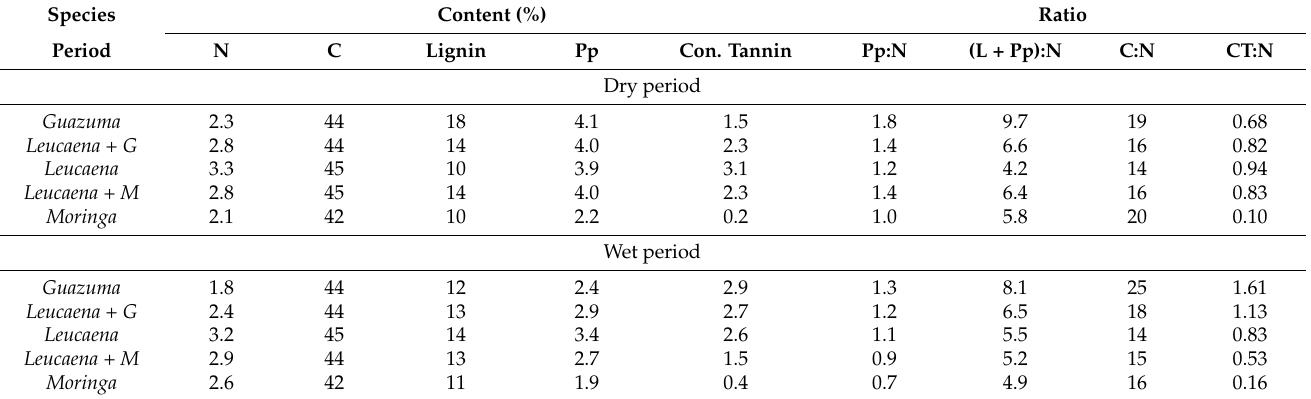
Table 2. Chemical composition of leaves from the different species used in the decomposition experiment.